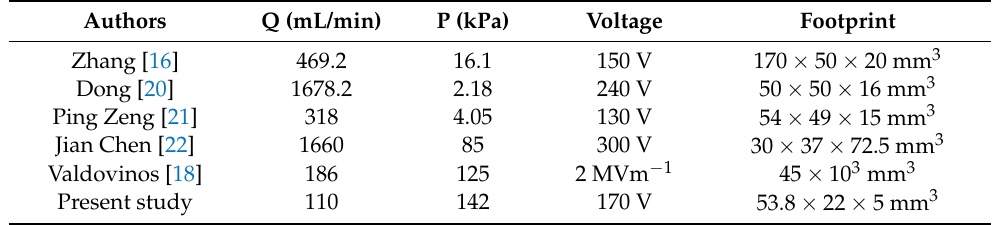
Table 3. Current situation of piezoelectric micropumps at home and abroad.